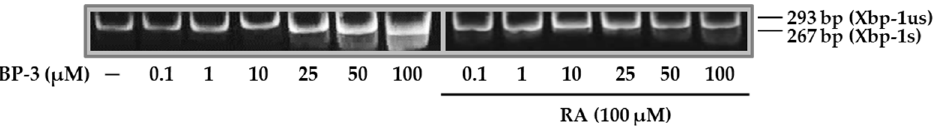
Figure 5. The expression of unspliced and spliced X-box binding protein 1 ( Xbp-1us and Xbp-1s ) in fibroblasts treated with benzophenone-3 (BP-3) alone and in combination with rosmarinic acid (RA). The PCR products were analyzed on 8% polyacrylamide gel.